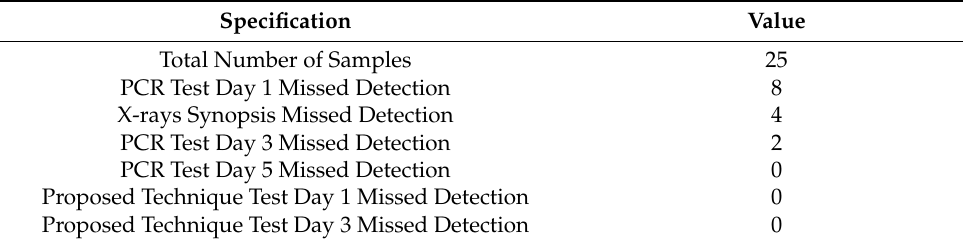
Table 4. Statistical analysis of false detection with conventional and proposed